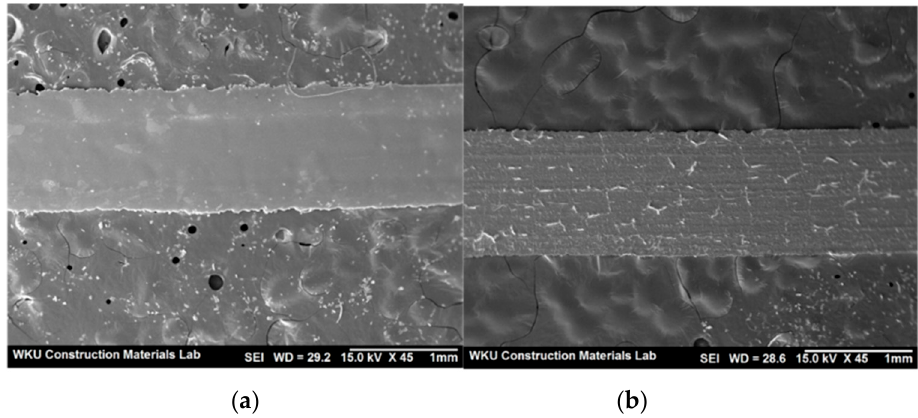
Figure 2. SEM images of amorphous metallic fibers (AMFs): ( a ) front side, ( b ) back side.